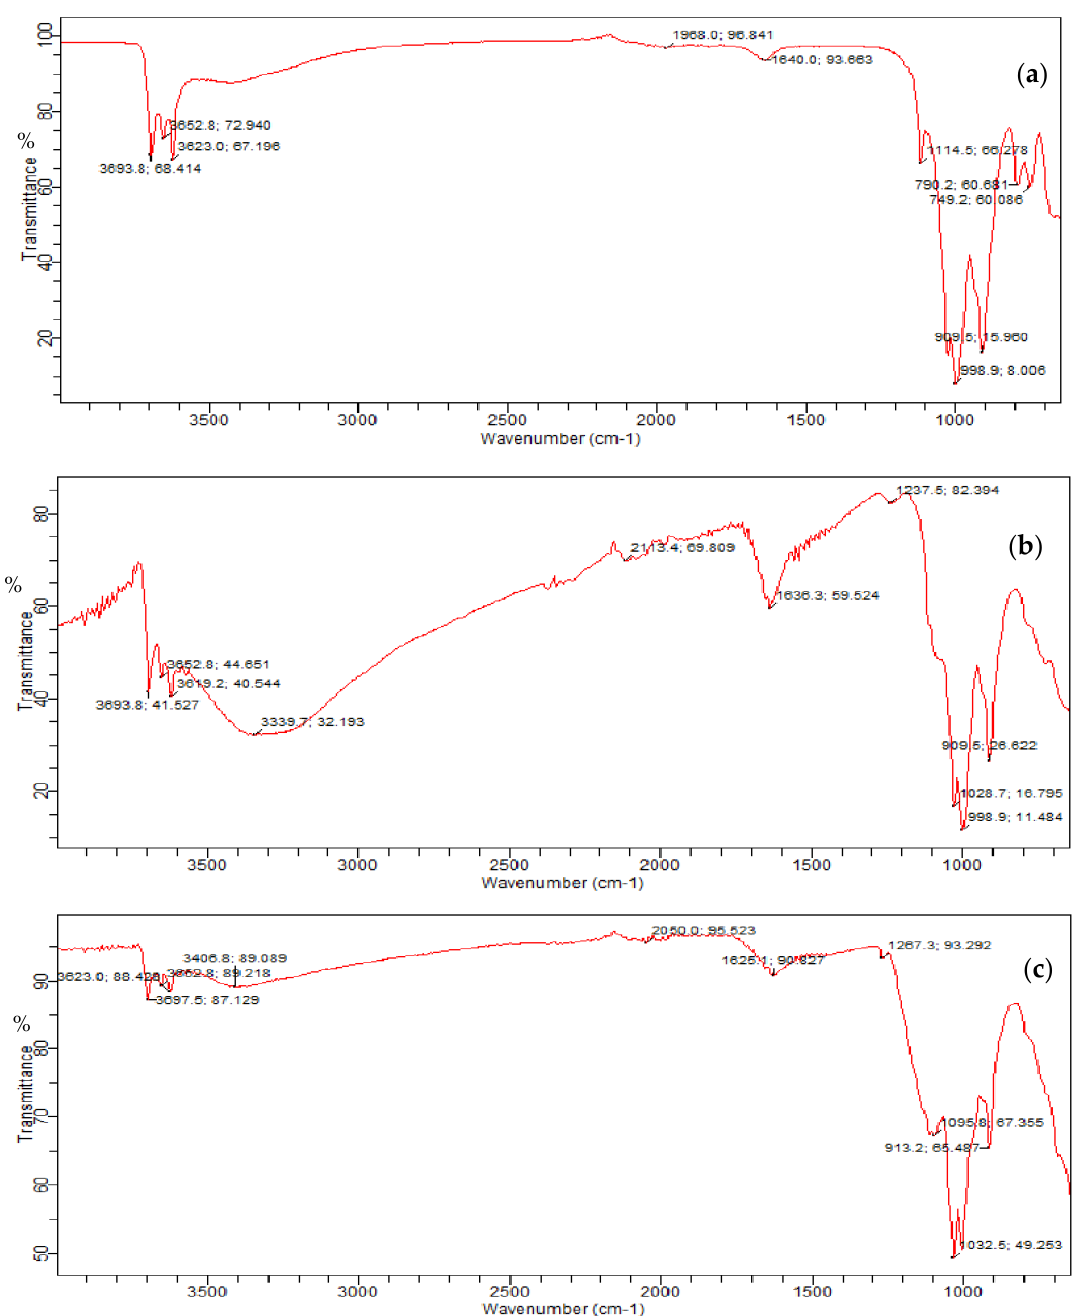
Figure 3. FT-IR spectra of the ( a ) raw montmorillonite (MM), ( b ) doped titanium composite and ( c ) the tripartite magnetic composite.